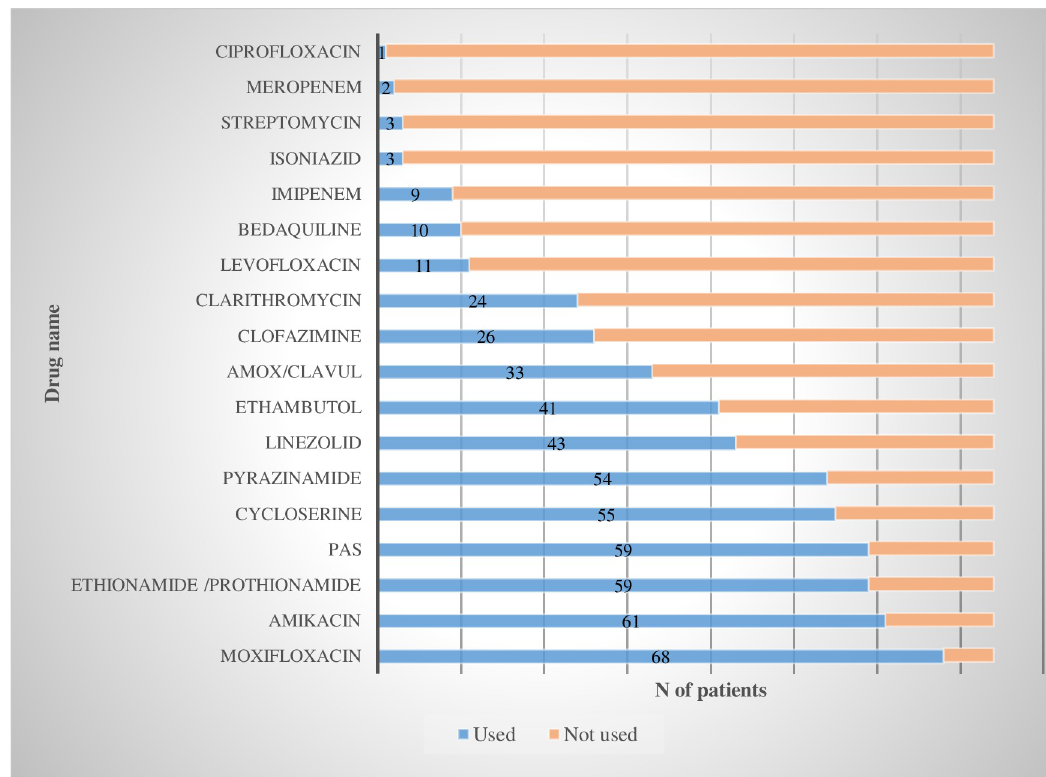
Fig 1. Regimen composition of 74 patients with MDR